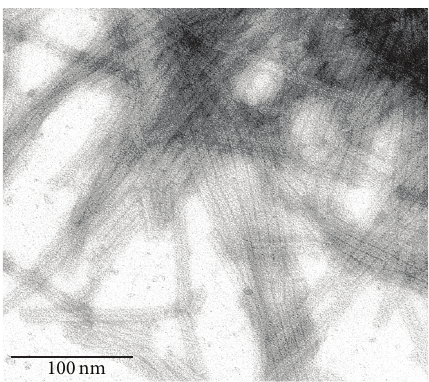
Figure 7: Chemical reduction of (dien)platinum on the TMV platform by hypophosphite. No additional staining was carried